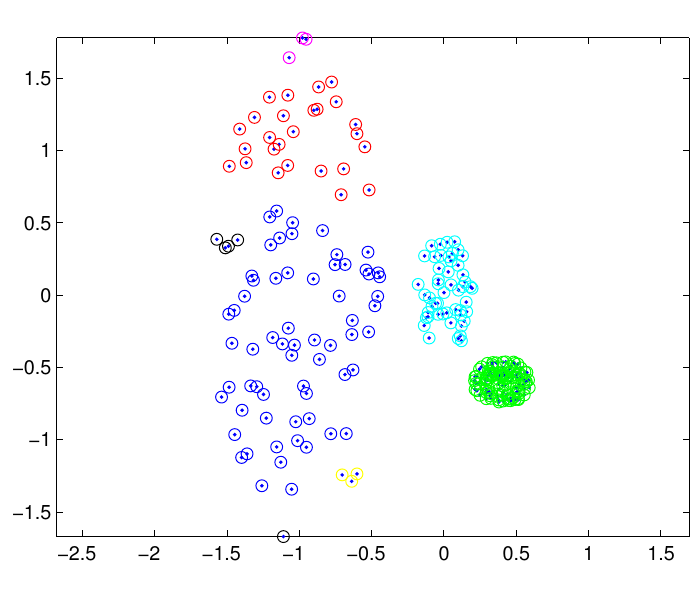
Figure 1. Measurements from three extended targets.